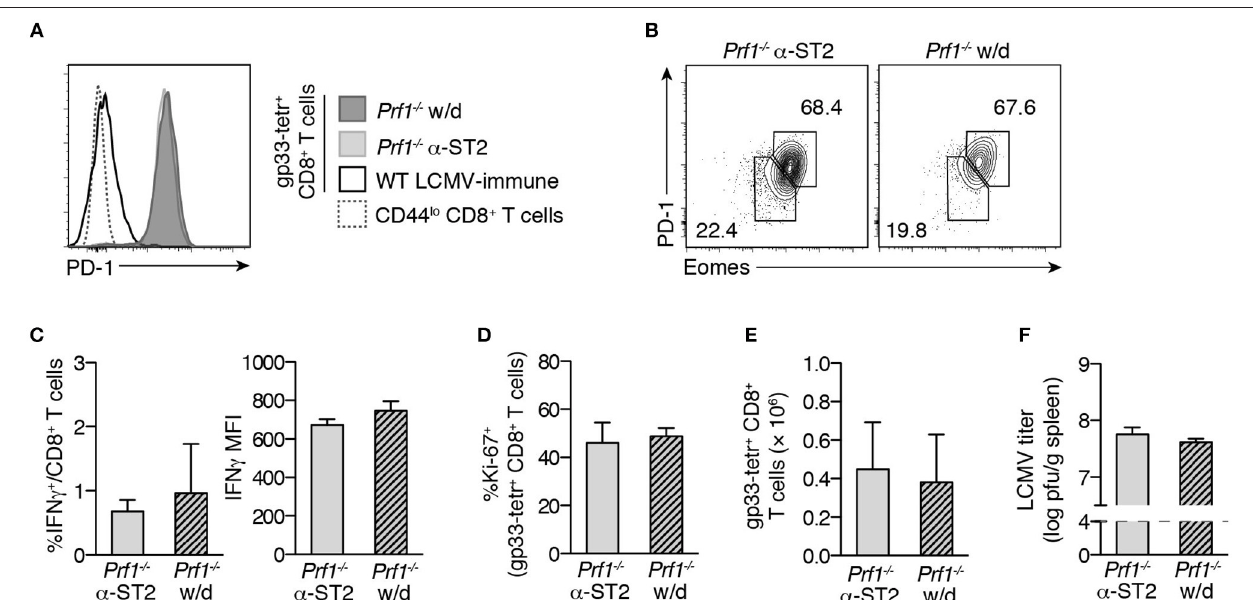
FIGURE 3 | Withdrawal of ST2 blockade does not reverse CD8 + T cell exhaustion. Prf1 − / − mice were infected with LCMV and either treated with α -ST2 antibody continually ( α -ST2) or were withdrawn (w/d) from α -ST2 treatment after day 15 p.i. and thereafter switched to isotype control antibody. Antibody treatments were administered every other day, beginning on day 3 p.i. Splenocytes were assessed on day 30 p.i. N = 3–4 mice/group. Bars represent mean ± SEM. Analyzed by Student’s two-tailed t -test. (A) Representative histograms gated on gp33-tetramer + CD8 + T cells, showing expression of PD-1. (B) Representative flow plots gated on gp33-tetramer + CD8 + T cells, showing expression of Eomes and PD-1. Numbers indicate the frequency of cells within the adjacent gate. (C) Frequency and IFN γ MFI of CD8 + T cells specifically producing IFN γ in response to in vitro gp33 peptide stimulation. (D) Frequencies of gp33-tetramer + CD8 + T cells expressing Ki-67. (E) Numbers of splenic gp33-specific CD8 + T cells. (F) Splenic LCMV titer. Dotted line indicates lower limit of detection of plaque